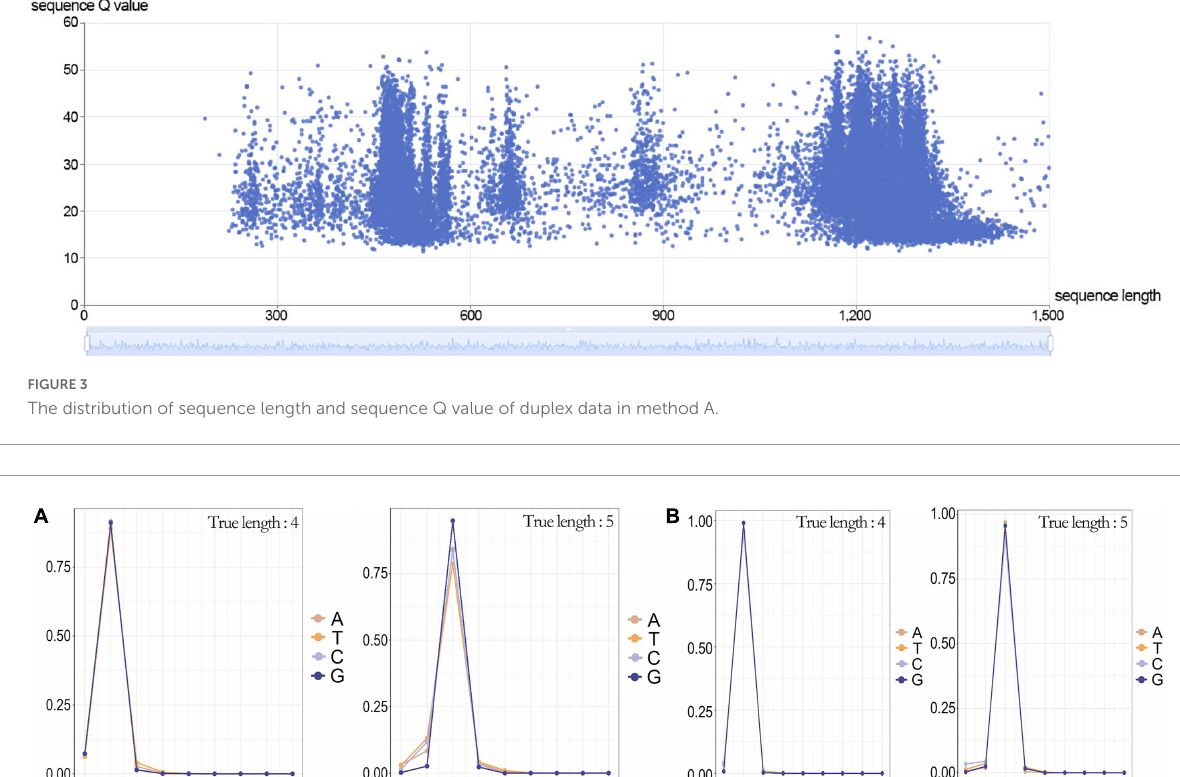
625.4 Mb data generated by flow cell R9.4.1 ( Figure 5 ).